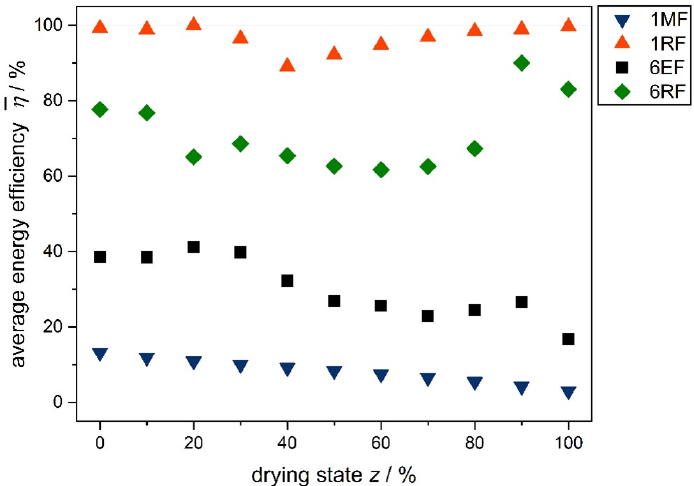
Figure 9. Average energy efficiency of the respective control concepts plotted over the drying state, calculated from the electromagnetic simulations.